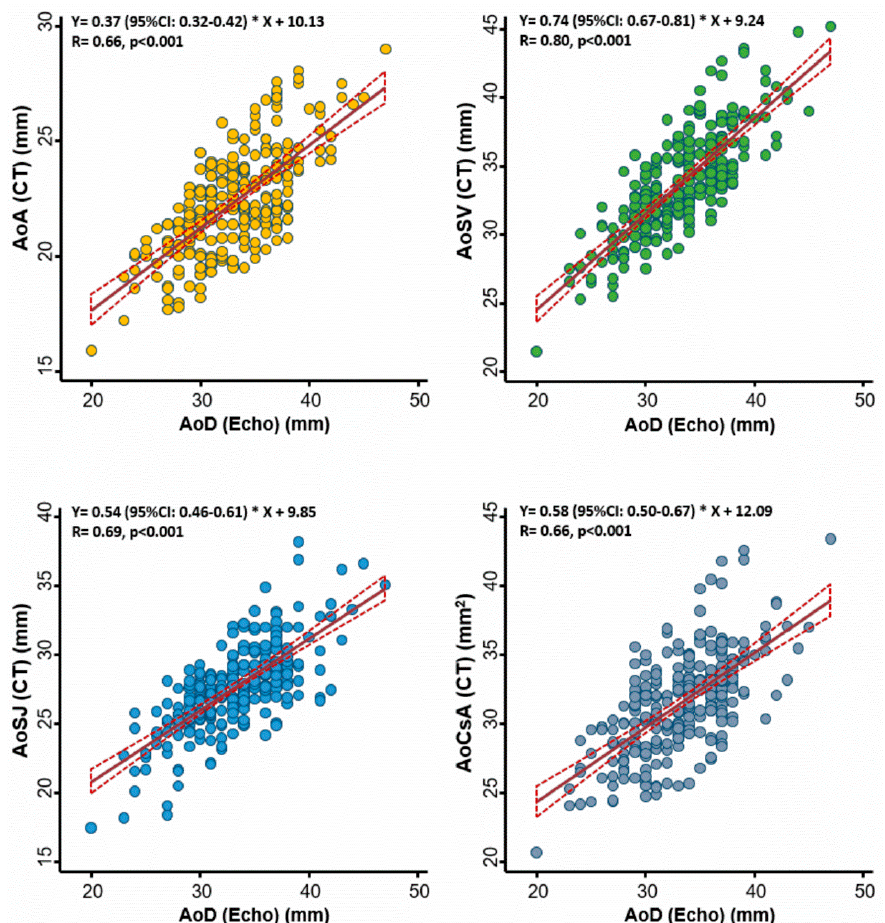
Figure 1. Association between echocardiography- and computed tomography (CT)-defined aortic root diameter at different levels of the aortic root. The best correlation was observed at the level of the aortic sinuses of Valsalva. AoA: aortic annulus; AoSV: aortic sinuses of Valsalva; AoSJ: sinotubular junction; AoCsA: cross-sectional area of the aortic annulus; AoD: aortic root diameter; Echo: echocardiography.